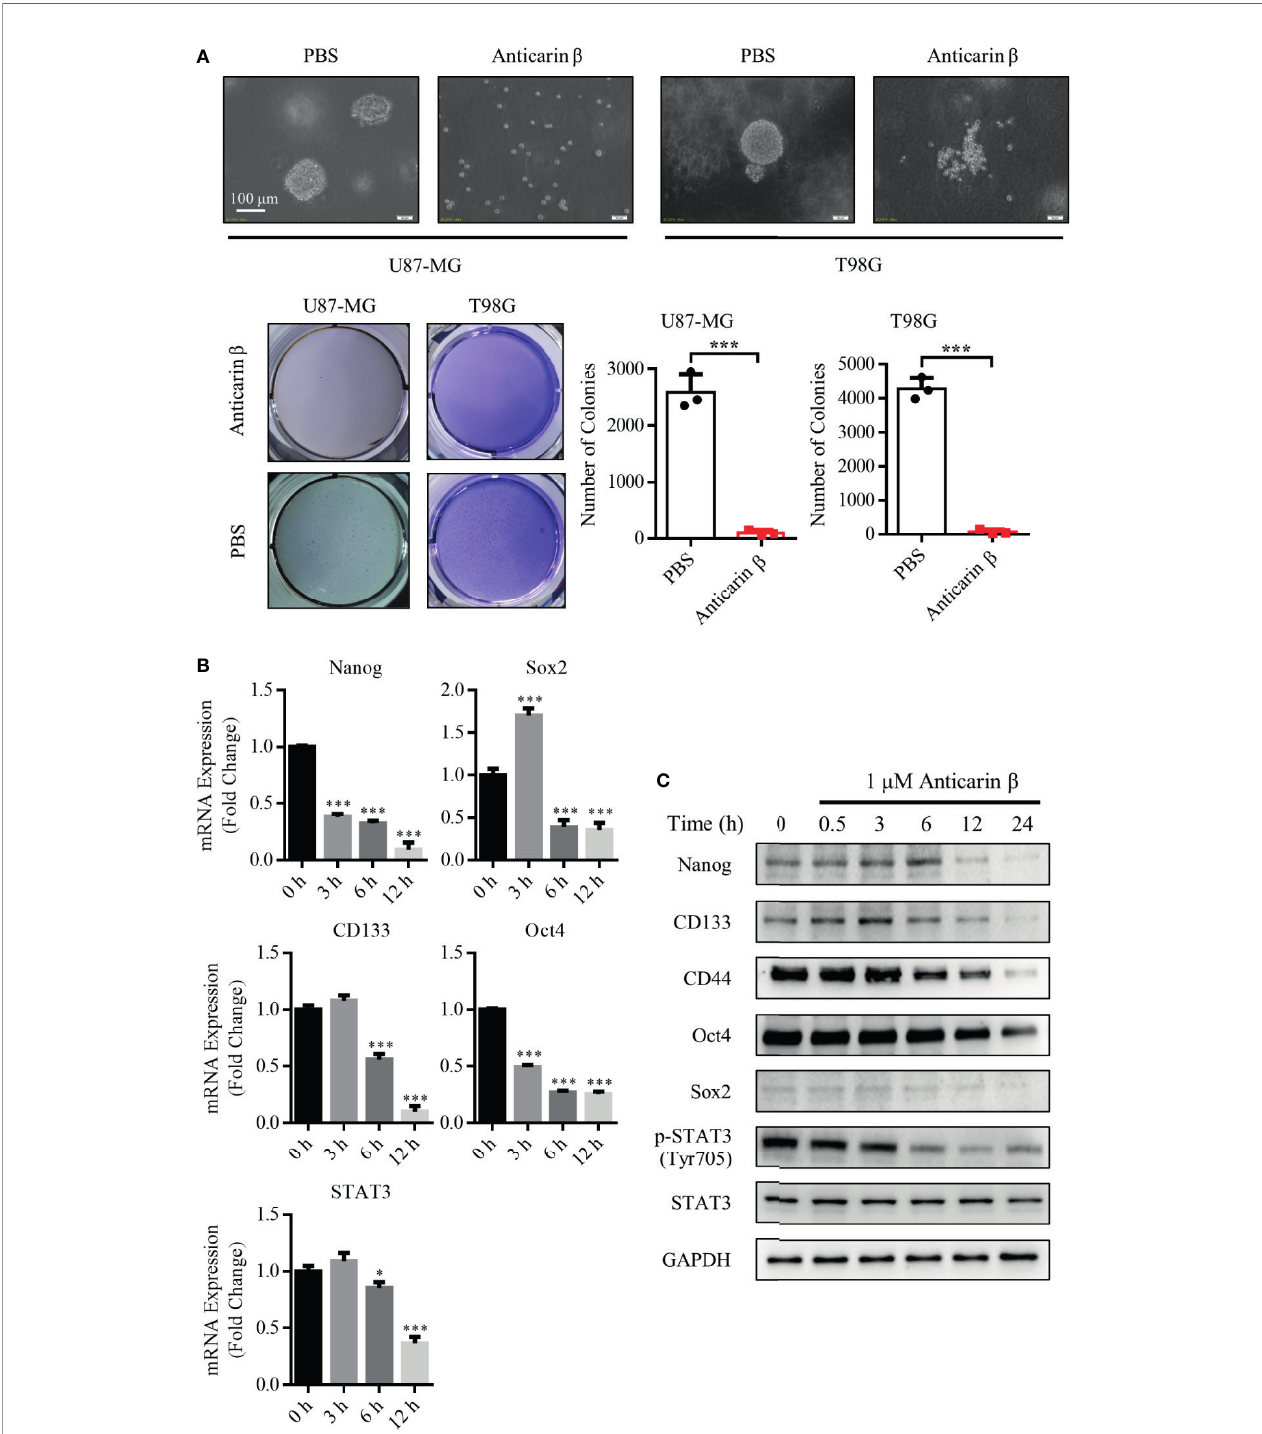
FIGURE 3 | Anticarin b inhibits the stemness of human glioma cells. (A) Human glioma cell lines U87-MG and T98G clonal sphere morphology were damaged following treatment with anticarin b (1 m M). Cells sphere formation was stained with 4% paraformaldehyde and 0.005% crystal violet for 2 hours. The quantitative data of the number of clonal spheres were shown. (B) The mRNA expression of the stemness-related genes was measured in U87-MG cells with anticarin b (1 m M) for different times using RT-qPCR analysis. (C) The expression of the stemness-related proteins and CD44 was detected by Western Blotting in U87-MG cells after treated with anticarin b (1 m M) for different times. Data are presented as mean ± s.d. of three independent experiments conducted in duplicate, * P < 0.05 and *** P < 0.001 versus the control